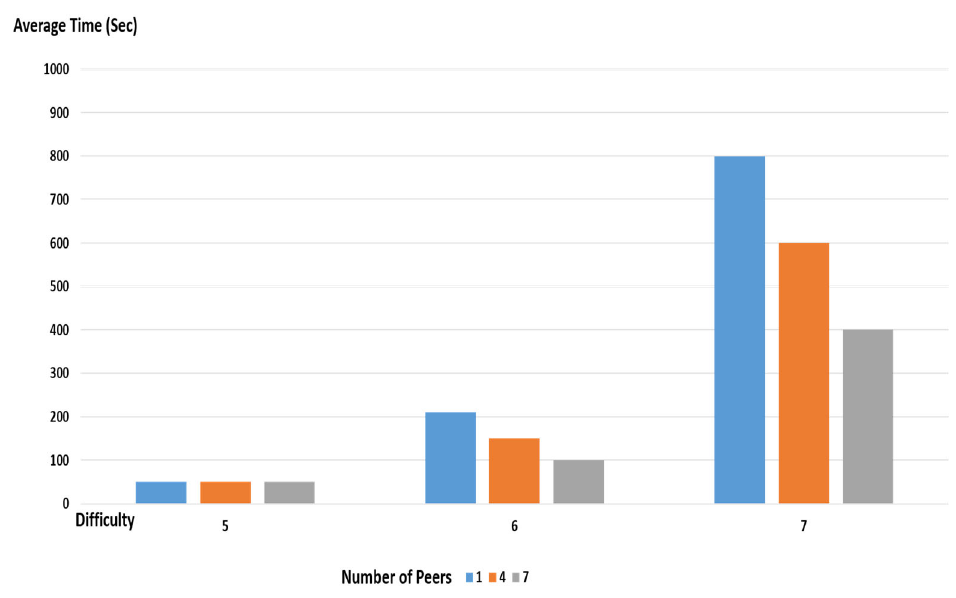
Figure 10. Third scenario results (PSO-POW Model).